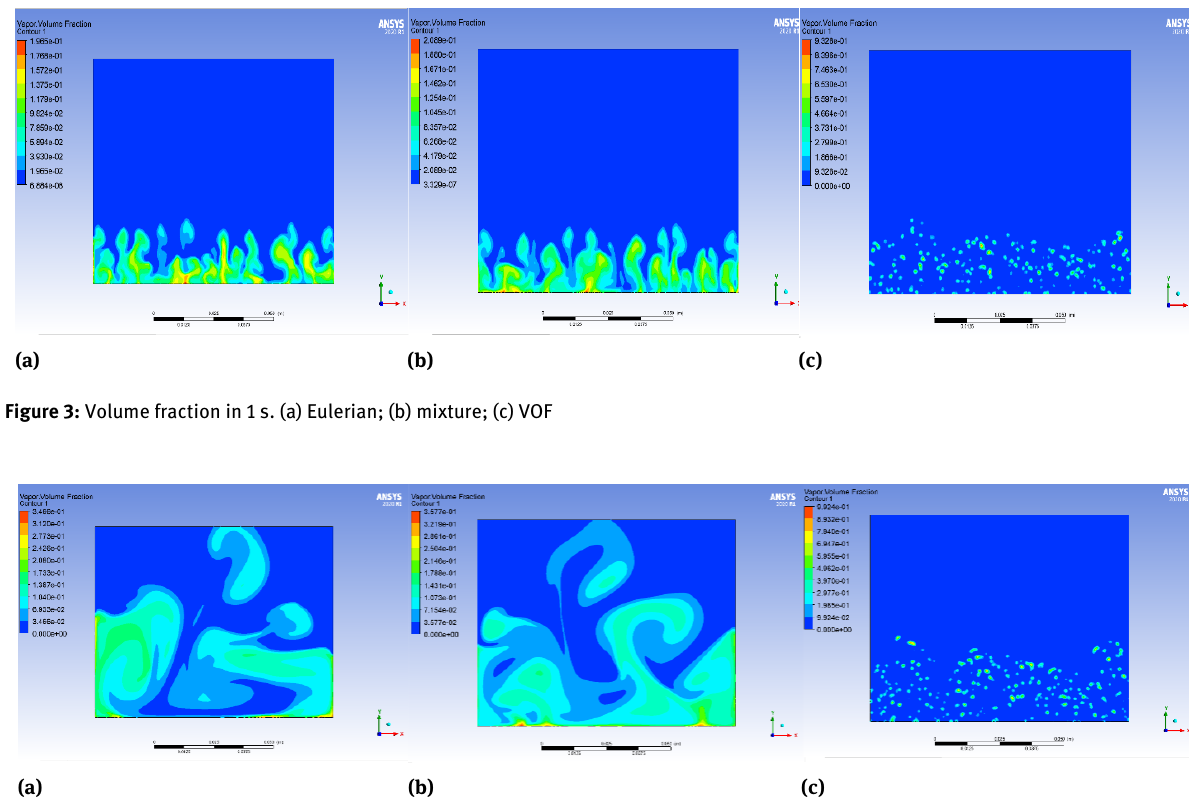
Figure 4: Volume fraction in 2 s. (a) Eulerian; (b) mixture; (c)